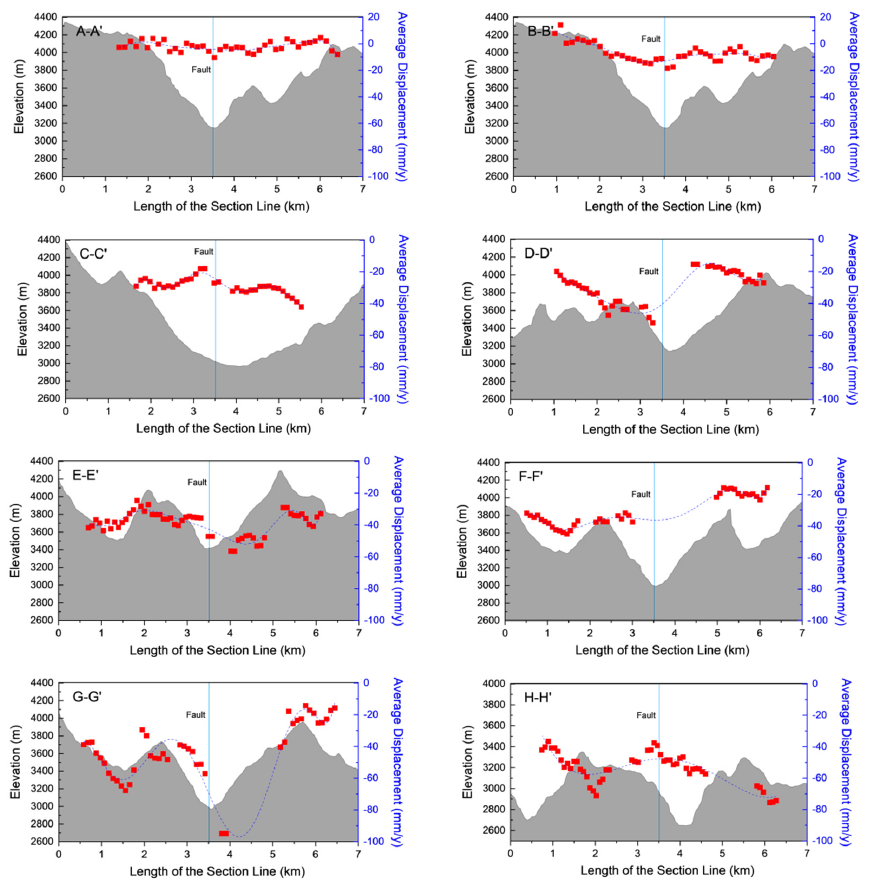
Figure 20. Velocity profile of 8 sections of the Huya fault along the fault strike. The post-earthquake deformation rate of points on A–A’ and B–B’ sections are rela- tively stable, between − 20~20 mm/y with a small subsidence center at the intersection of the fault and section lines, and the relative slip rate of the north and south walls is almost zero. The post-earthquake subsidence rate of each point on profile B–B’ has no obvious trend of change. The points on profile C–C’ show obvious differences in subsidence rates between the two sides of the fault, the south side shows a gradual decrease in the subsid- ence near the fault, and the north side shows a gradual increase in the subsidence near the fault; the relative slip rate of the north–south walls of the fault reaches 9.93 mm/y. The point displacement rate pattern on the D–D’ profile is just opposite to that on C–C’, the south wall increases while the north wall decreases, and the relative slip rate of the north– south walls reaches 15.65 mm/y. The overall deformation rate of the E–E’ profile fluctuates between − 20 and − 60, and the difference between the deformation rates of the north and south plates near the fault is 25.1 mm/y. The deformation rate of the F–F’ profile generally